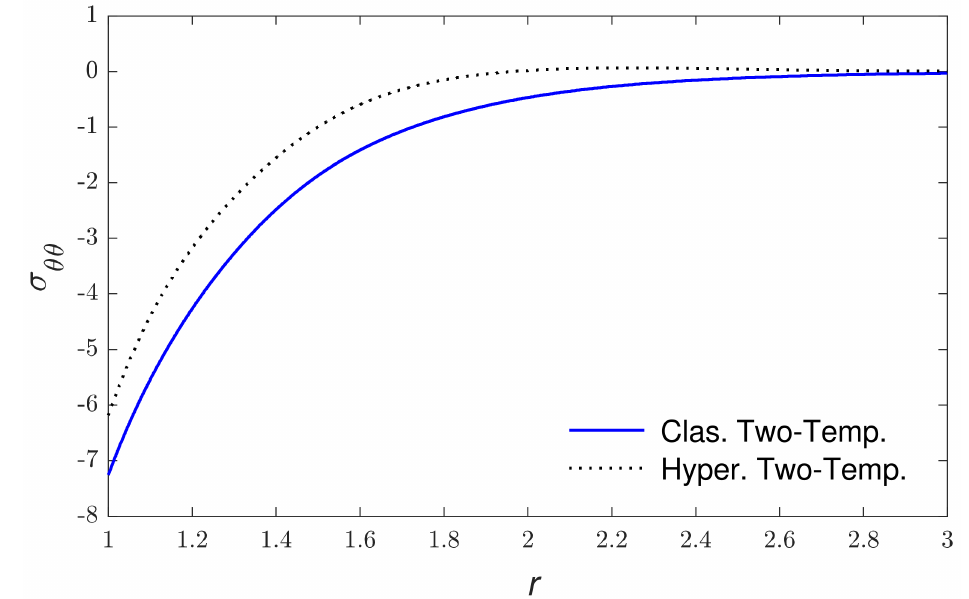
Figure 7. The hoop stress variations versus the redial